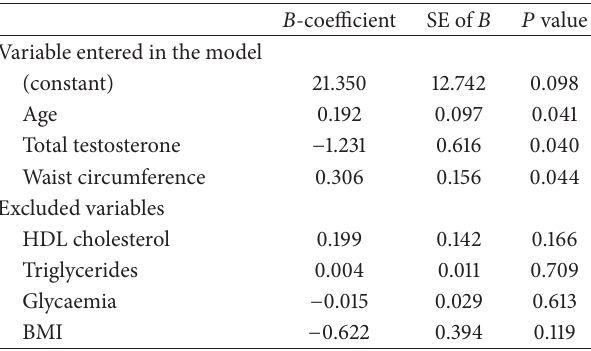
Table 4: Linear regression analysis for the determinants of pulse pressure in the study population.